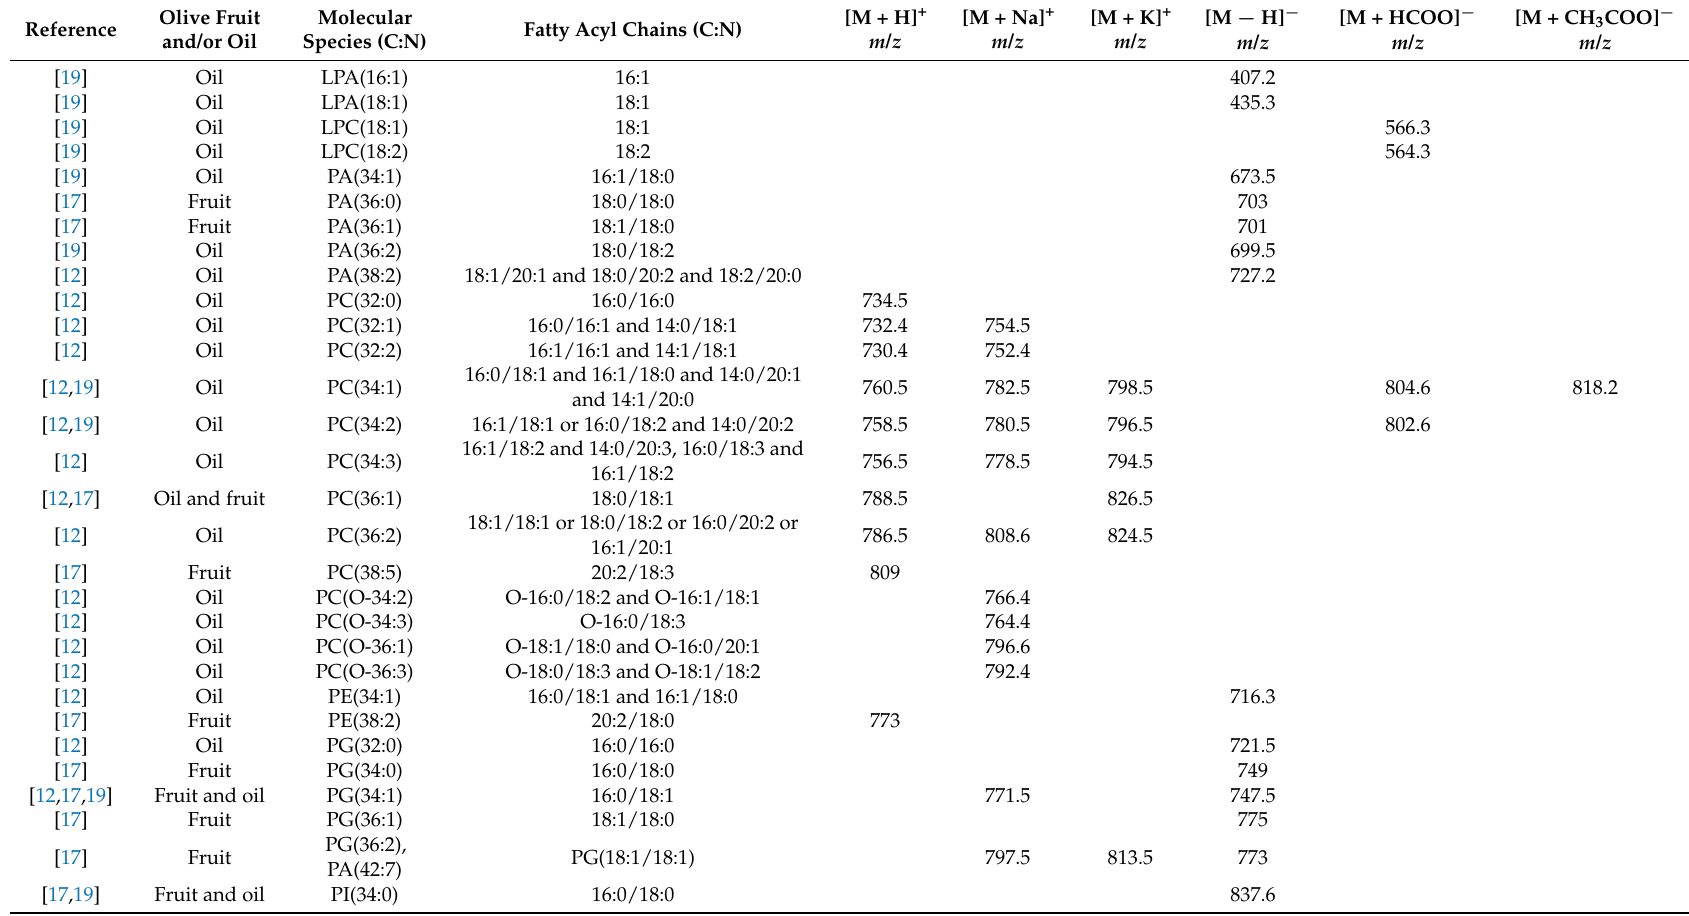
Table 2. List of glycerophospholipid molecular species identified in olives and olive oil through mass spectrometry-based lipidomic approaches.